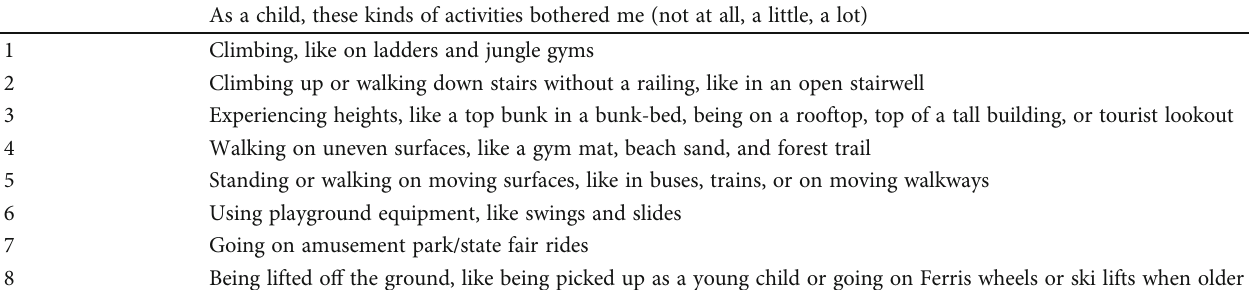
Table 1: Items from the Provisional Gravitational Insecurity Index.